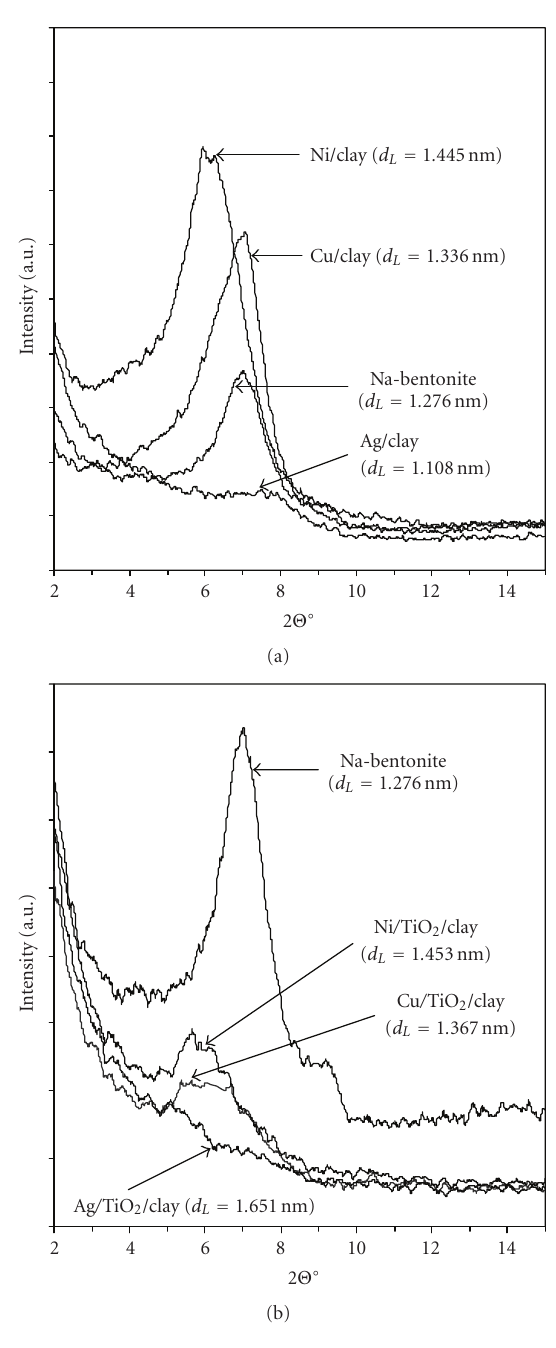
Figure 1: X-ray di ff raction (XRD) patterns of (a) Me/clay and (b) Me/TiO 2 /clay